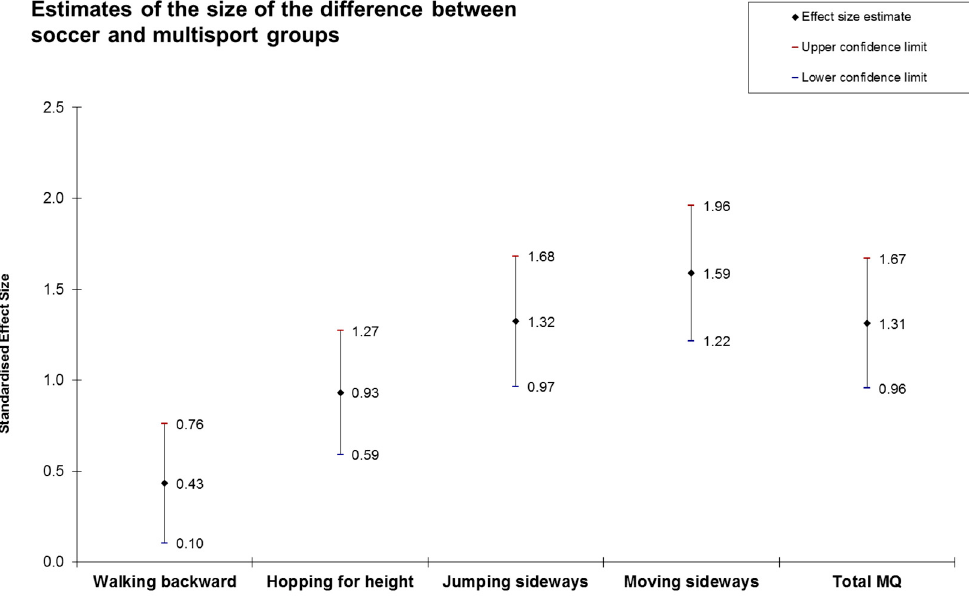
Figure 1. Standardized mean di ff erences and 95% confidence intervals (Cohen’s d ± 95%) between soccer and multisport in gross motor coordination.